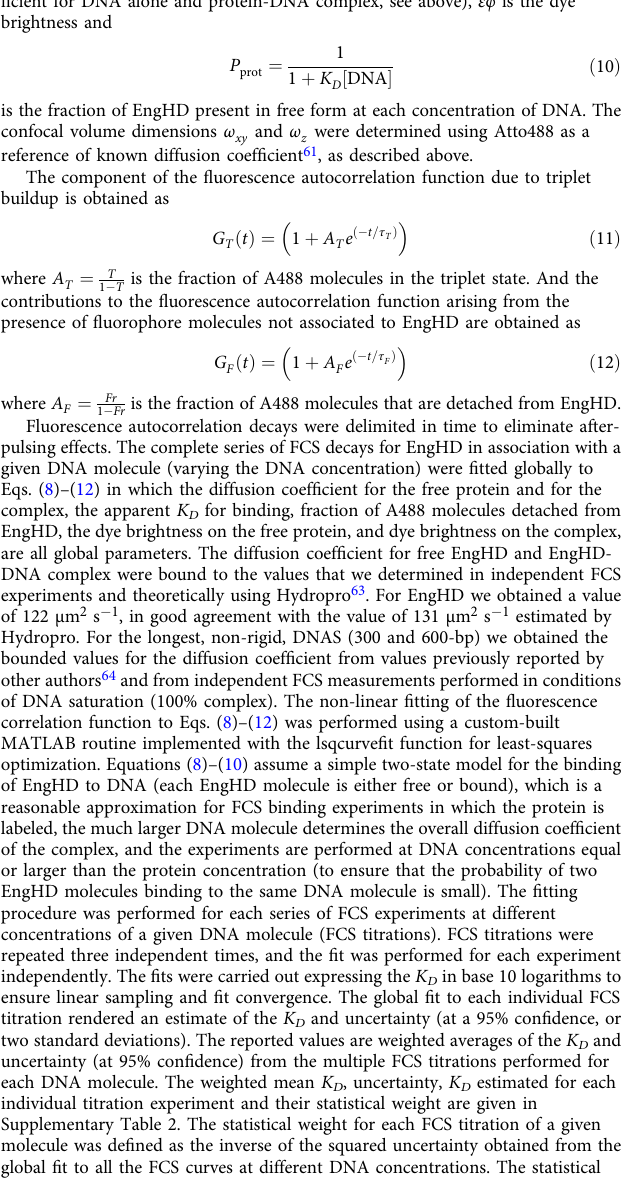
Supplementary Table 2. The statistical weight for each FCS titration of a given molecule was de fi ned as the inverse of the squared uncertainty obtained from the global fi t to all the FCS curves at different DNA concentrations. The